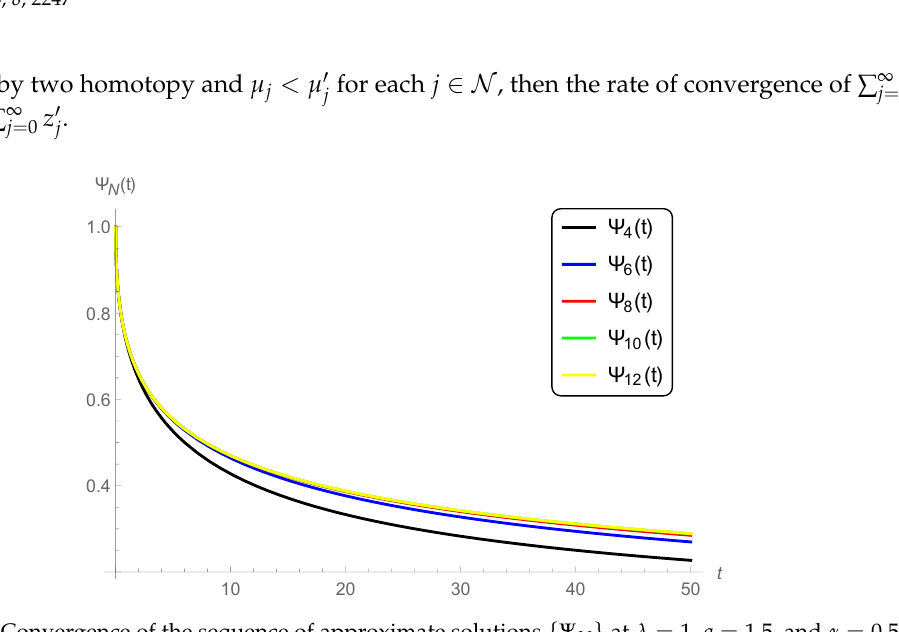
Figure 1. Convergence of the sequence of approximate solutions { Ψ N } at λ = 1, q = 1.5, and α = 0.5. Table 1. List of the values of µ i when λ = 1 and q = 1.4 at three different values of α